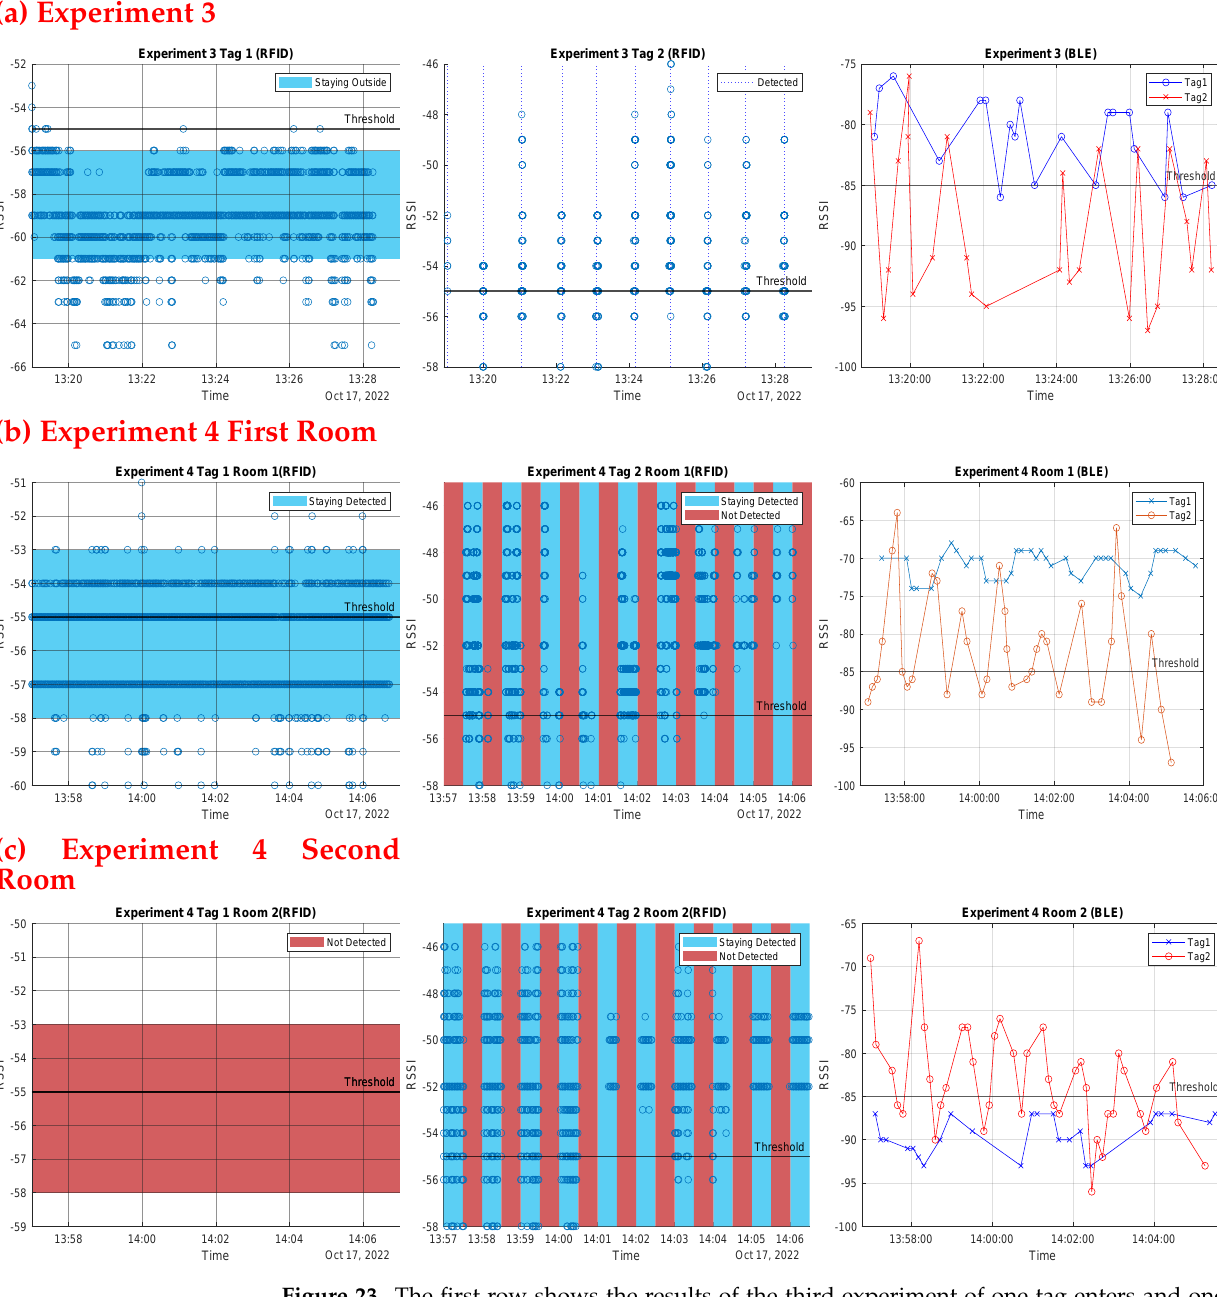
Figure 23. The first row shows the results of the third experiment of one tag enters and one tag outside. The second row shows the results of the forth experiment in the first room, and the third row shows the results of the forth experiment in the second room. The first column represents the results of the first RFID tag, the second column represents the results of the second RFID tag, and the last column represents the results of the two BLE tags together in each experiment. In the third experiment, for RFID, the first tag is always detected as staying outside (shown in blue region below threshold) while second tag was detected correctly, the BLE system had some miss-outs. In the fourth experiment first room, for RFID, the first tag is always detected as staying (shown in blue region above threshold) while second tag’s staying (blue regions) and leaving (red regions) durations were detected, also the BLE system worked fine. In the second room, the only difference is that the first tag was not detected (shown in red